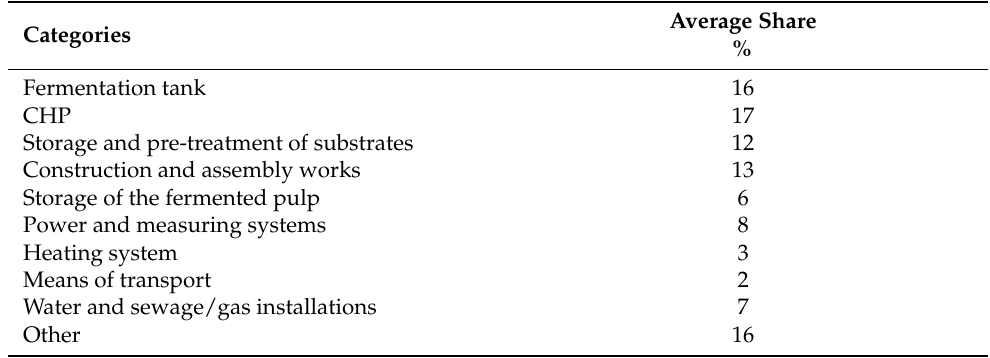
Table 1. Structure of investment categories for a silage-based biogas plant and maize slurry with a capacity of 0.86 MW el